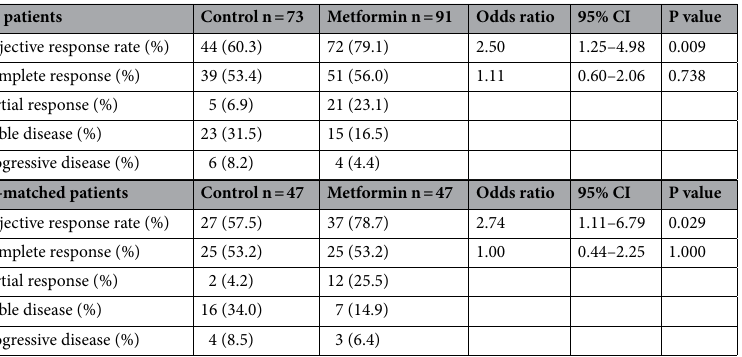
Table 2. Initial radiological response to TACE according to metformin administration. Objective response rate: complete response + partial response.